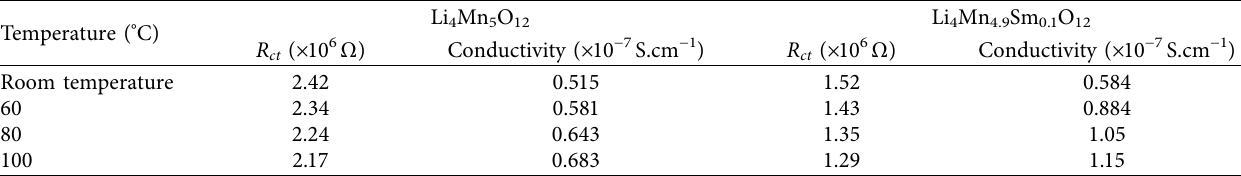
Table 3: Electrical parameters of LM and